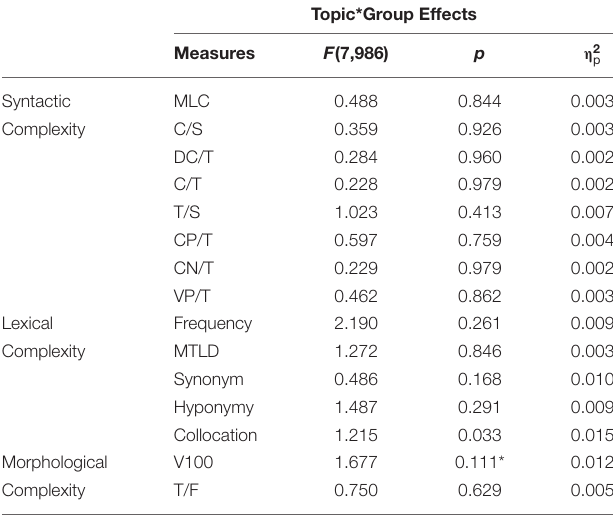
TABLE 8 | Results of two-way